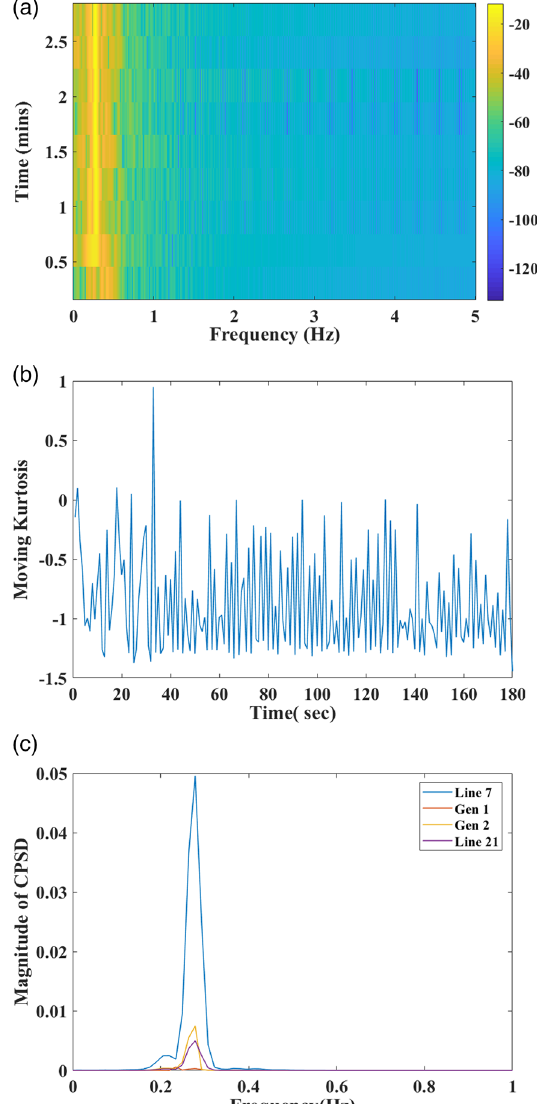
Fig. 11 a PSD of the selected DMAP. b Excess kurtosis. c Magnitude of CPSD between the selected DMAP and raw PMU data from different buses associated with generation